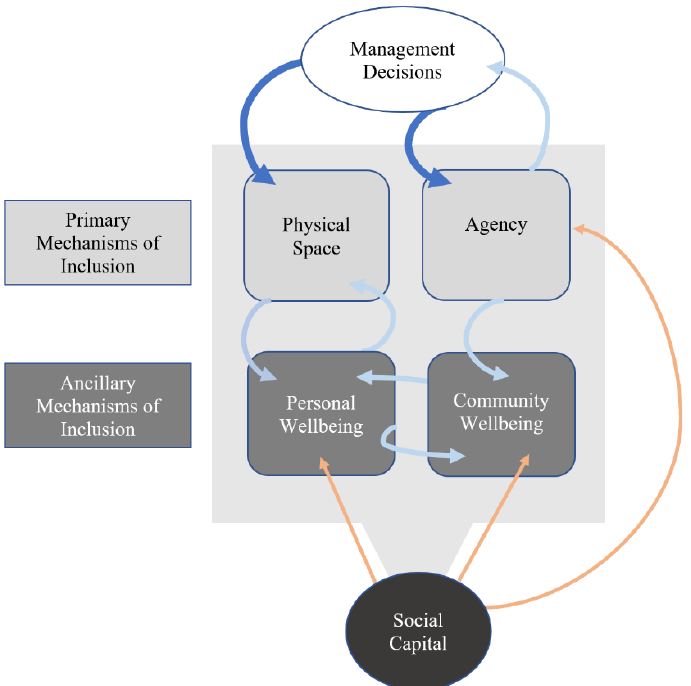
Figure 1. Conceptual framework detailing the interactions between garden management inputs, the analytical categories from our study, and the outcome of social capital. The dark blue arrows document the impacts of management decisions on mechanisms of inclusion. The light blue arrows indicate feedback relationships between gardener activities and the mechanisms of inclusion. The orange arrows indicate scholarly connections between social capital and the mechanisms of inclusion [34,42].